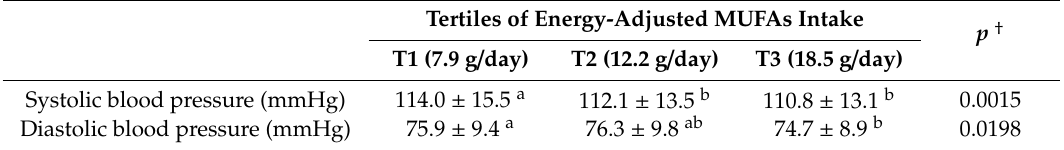
Table 3. Blood pressure after 4-year follow-up according to energy-adjusted * dietary MUFAs